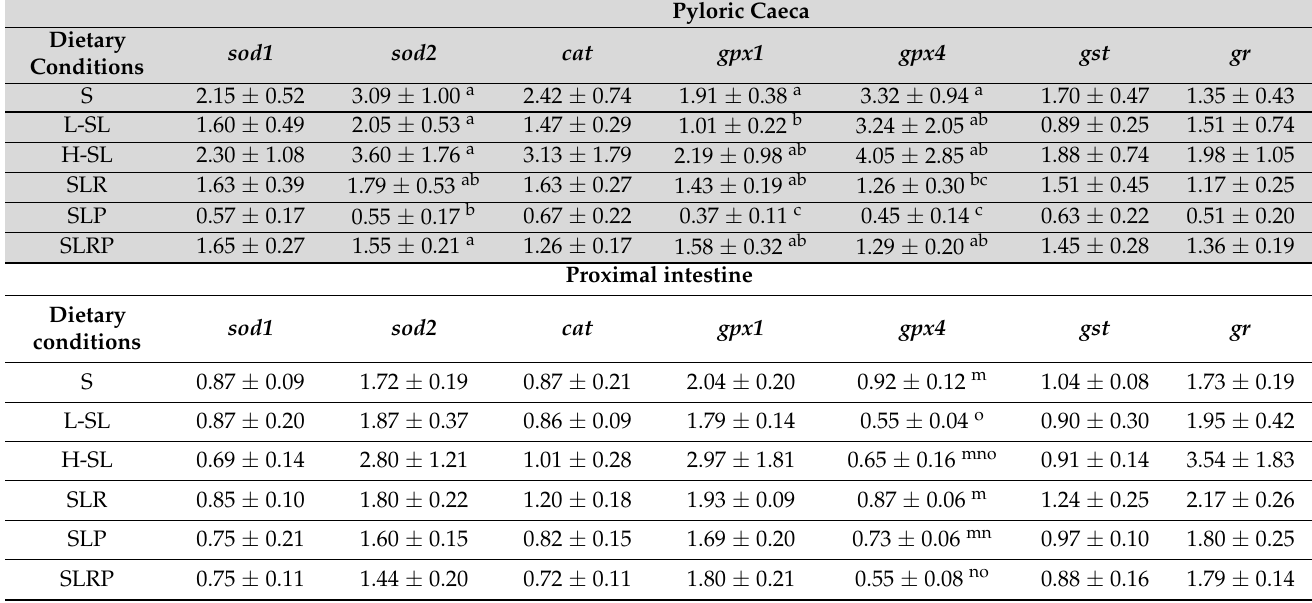
Table 6. Relative gene expression of antioxidant enzymes in pyloric caeca and proximal intestine 24 h post-feeding in sea bream fed the experimental